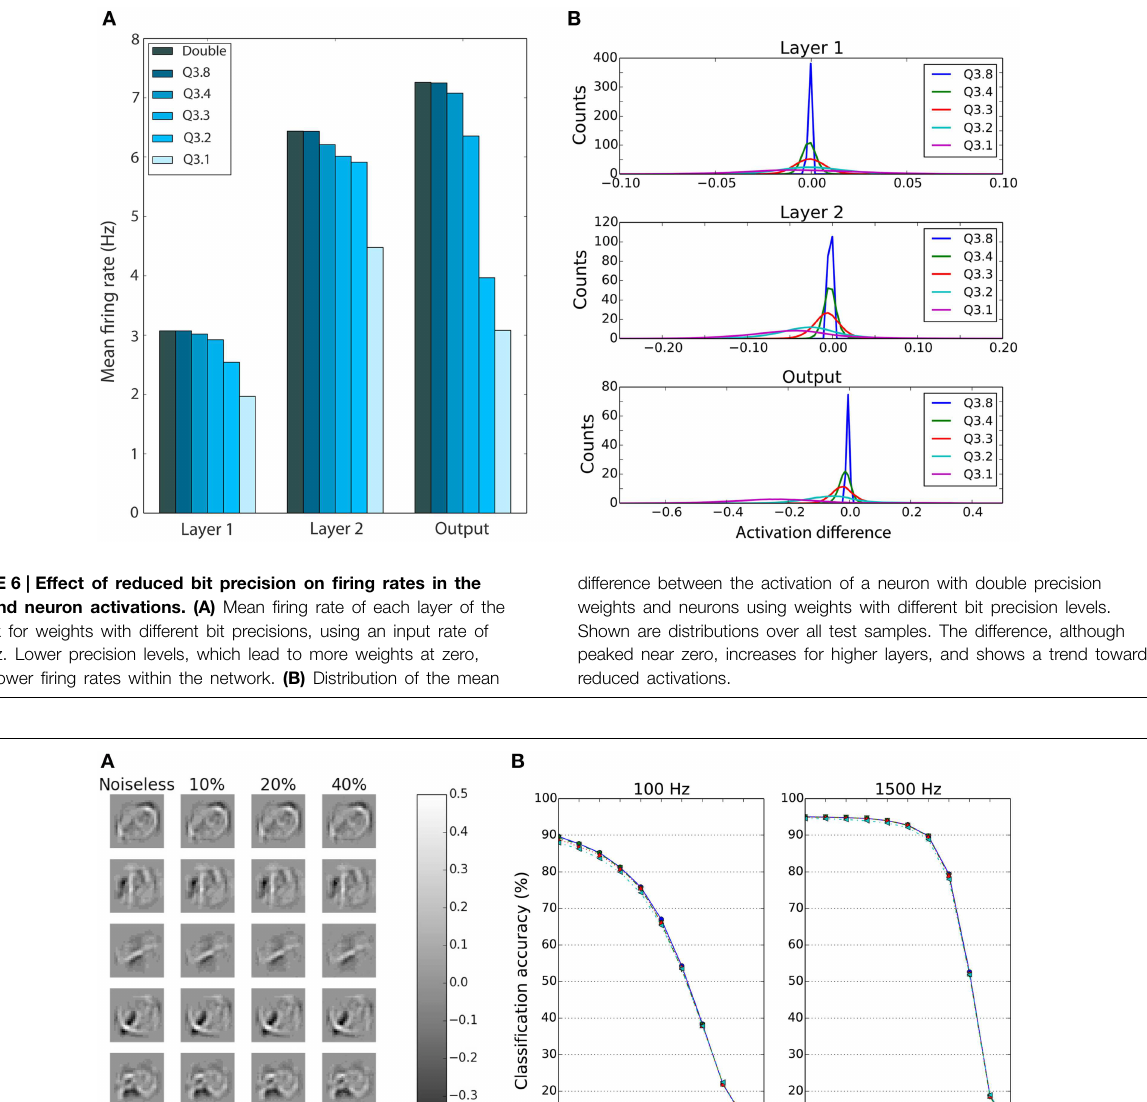
FIGURE 7 | Effect of Gaussian weight variance on the performance of spiking DBNs. (A) Receptive fields of 6 representative neurons in the first hidden layer after perturbation with Gaussian weight variance of different CVs. (B) Impact of Gaussian weight variance on classification accuracy. The